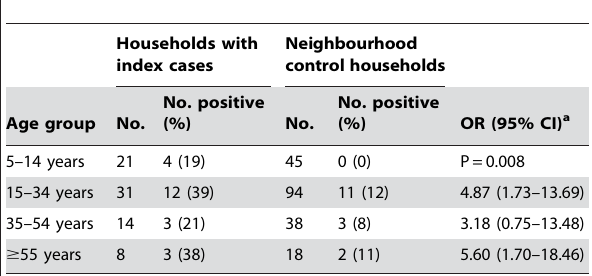
Table 2. Prevalence of anti- Leptospira antibodies among members of households with an index case of severe leptospirosis and neighbourhood control households.